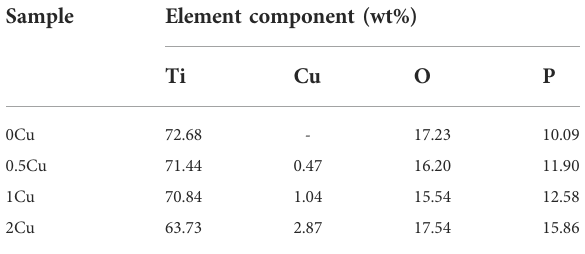
TABLE 2 Element component (wt%) on the surface of different